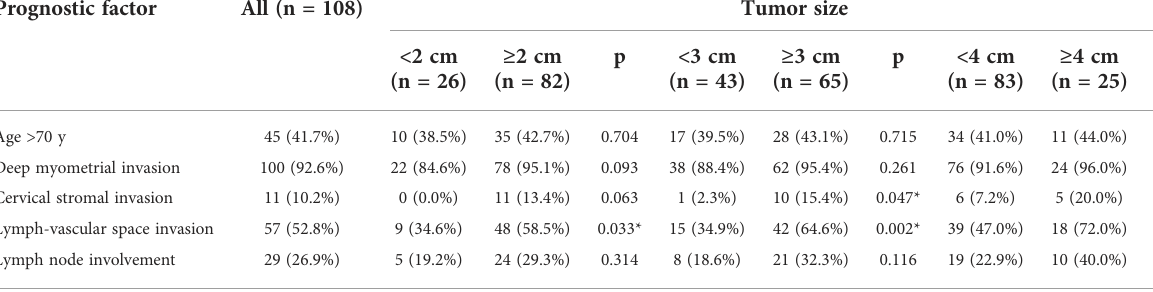
TABLE 2 Distribution of histological prognostic factors in the study population, overall and by tumor size. Prognostic